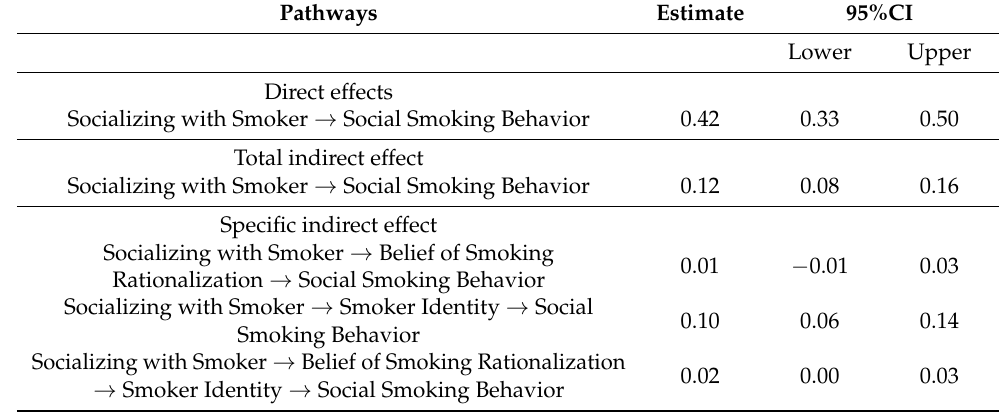
Table 2. Standardized estimates and 95% CIs for direct and indirect effects.